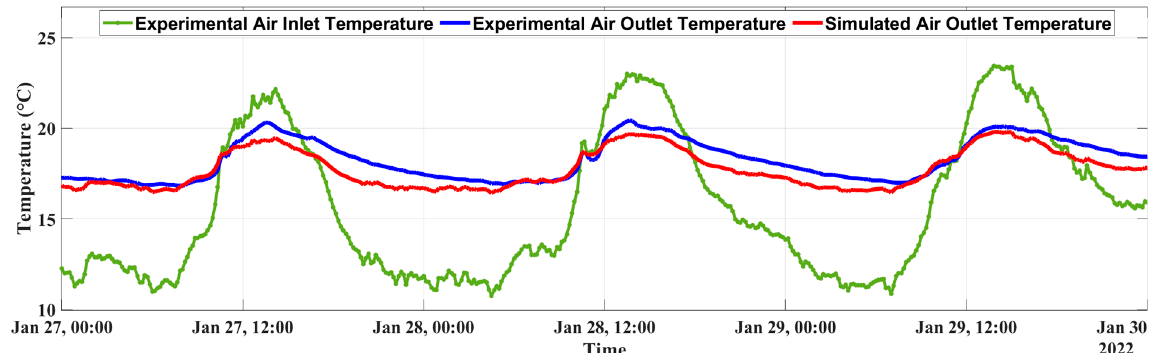
Figure 18. Experimental and simulation results of the deployed EAHE system (cooling behavior from 27 to 29 January 2022).